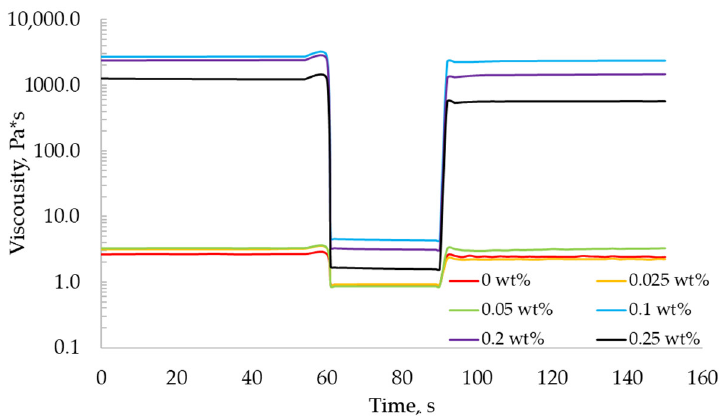
Figure 3. Viscosity as a function of time for the recovery test for “ink” made of 2 wt% sodium alginate and calcium chloride with concentrations of 0, 0.025, 0.05, 0.1, 0.2 and 0.25 wt% (logarithmic axes).